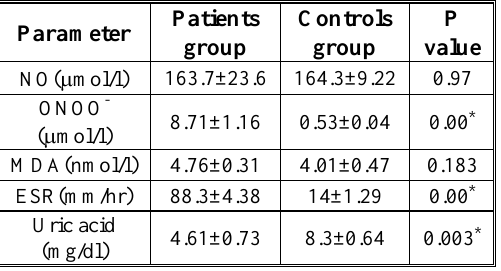
NO: Nitric oxide ONOO - :Peroxynitrite